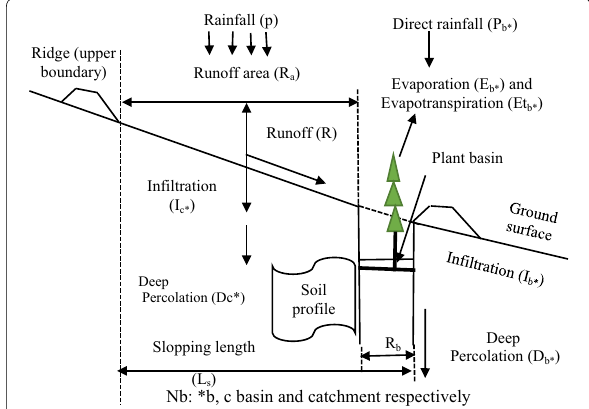
Fig. 11 Sketch of water harvesting process in a micro catchment (After Ali et al.